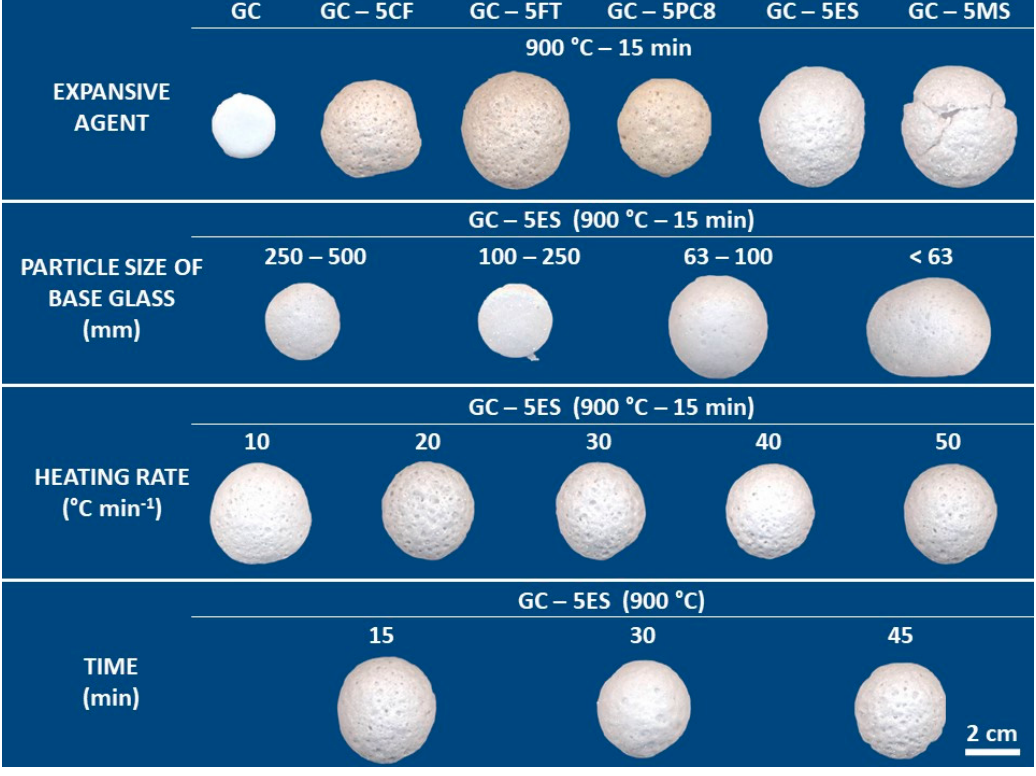
Figure 3. Appearance of the glass lightweight aggregates after the expansion tests performed with different processing parameters on pressing pellets.